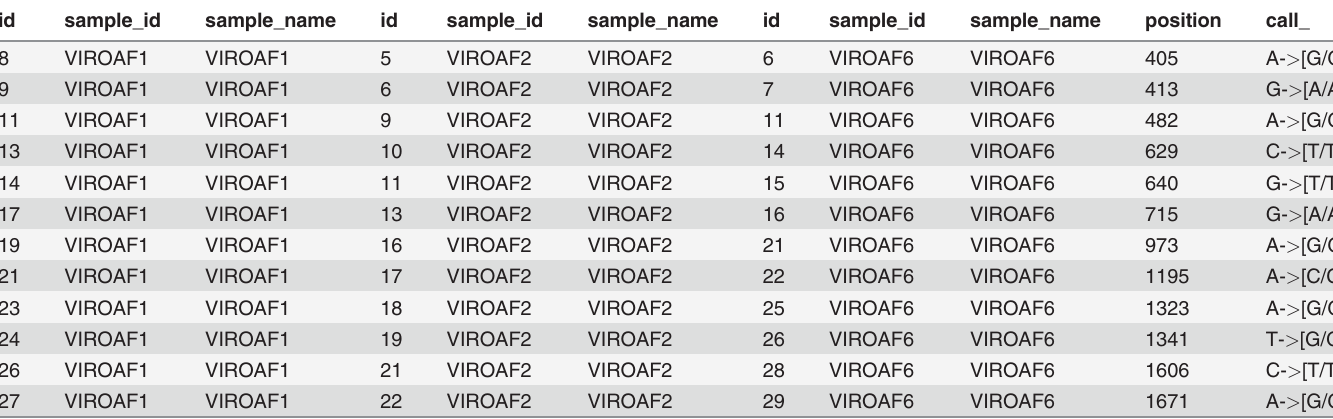
Table 5. The allelic list of the universal SNPs found in HA fragment ( “ AF1_HA_vs_AF2_HA_vs_AF3_HA_sim_all.csv ”